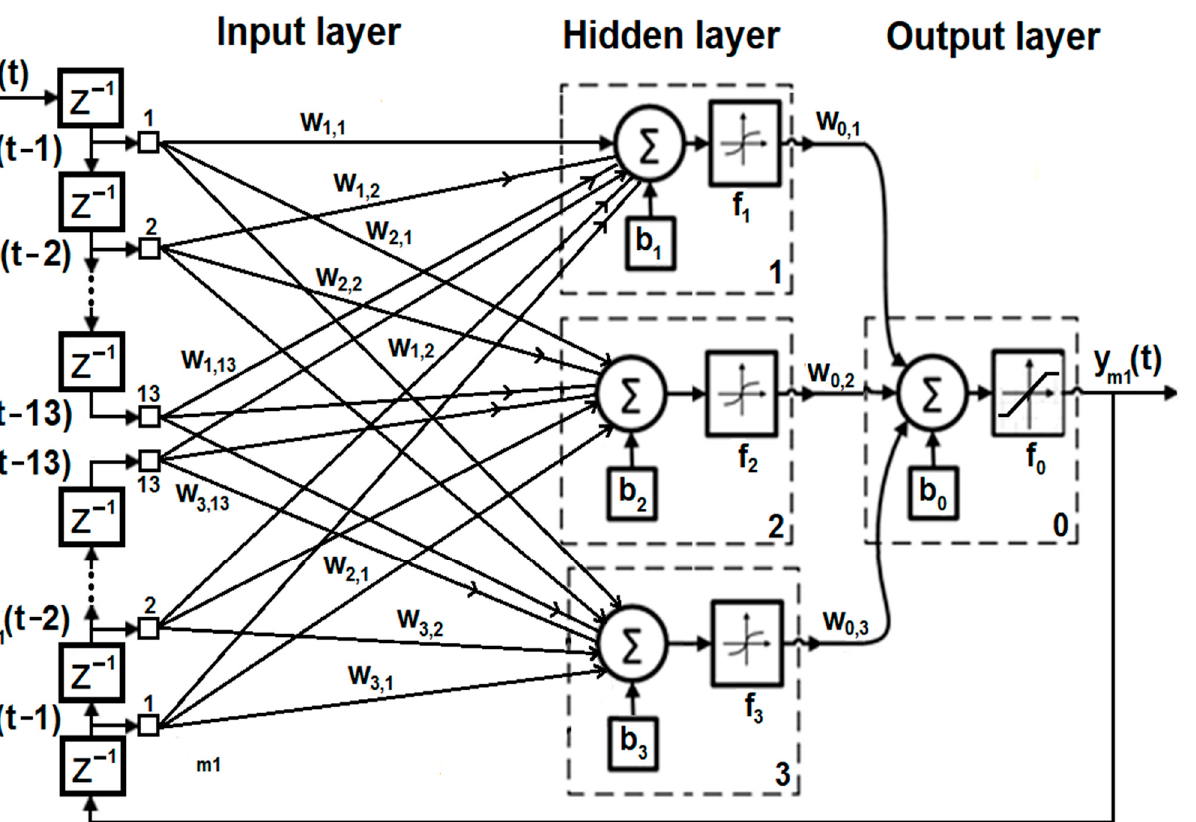
Figure 3. Architecture of the NARX-ANN-based model designed.